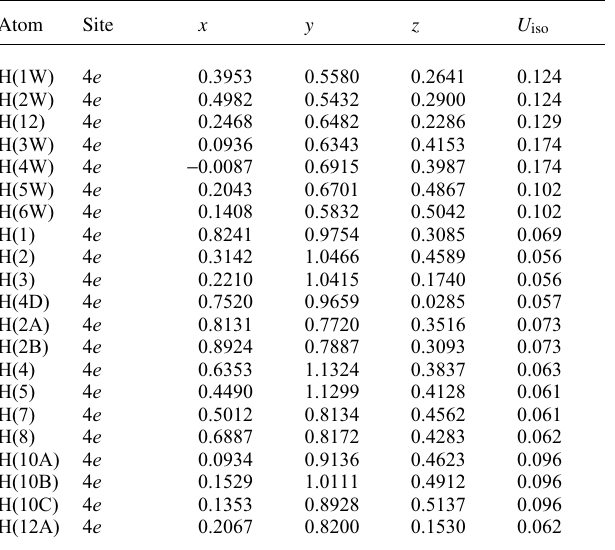
Table 2. Atomic coordinates and displacement parameters (in Å 2 )